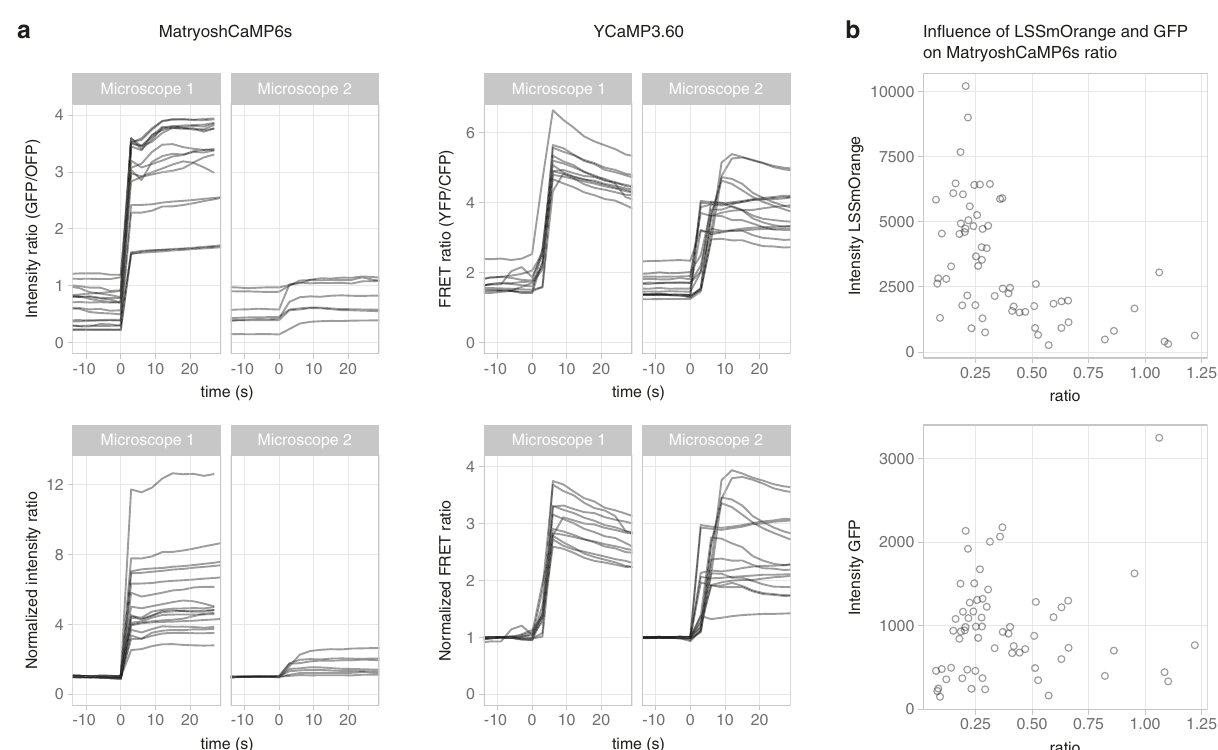
Fig. 1 Cell-to-cell variability in ratiometric measurements of MatryoshCaMP6s and YCaM3.60 in HeLa cells. a Time series of individual cells stimulated at t = 0 with 14 mM ionomycin combined with 5 mM CaCl 2 ( n = 7 to 17), taken on two different microscopes: a NIKON (1) and a ZEISS (2) setup. Top panels show the intensity ratio, bottom panels show the ratio normalized to the fi rst three frames. Both ratio and normalized ratio give a highly variable output. b The intensity of LSSmOrange of MatryoshCaMP6s (top panel) shows a clear in fl uence on the measured ratio, which is not the case for the green fl uorescence (bottom panel). Dots indicate individual cells ( n = 64), data for b were acquired with microscope 1. Source data are provided as a Source Data fi